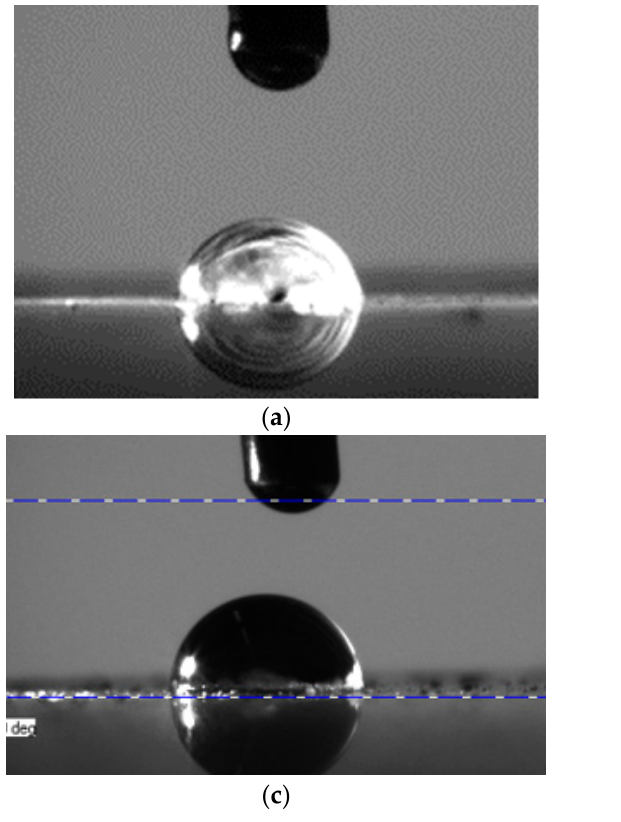
Figure 6. Photocatalytic wettability test results for ESpr and Spr samples: ( a ) Beginning of the assay, the initial contact angle of the water drop in the ESpr sample; ( b ) End of the assay, the final contact angle of the water drop in ESpr sample after irradiating with UV light; ( c ) Beginning of the assay, the initial contact angle of the water drop in Spr sample; ( d ) End of the assay, the final contact angle of the water drop in Spr sample after irradiating with UV light.